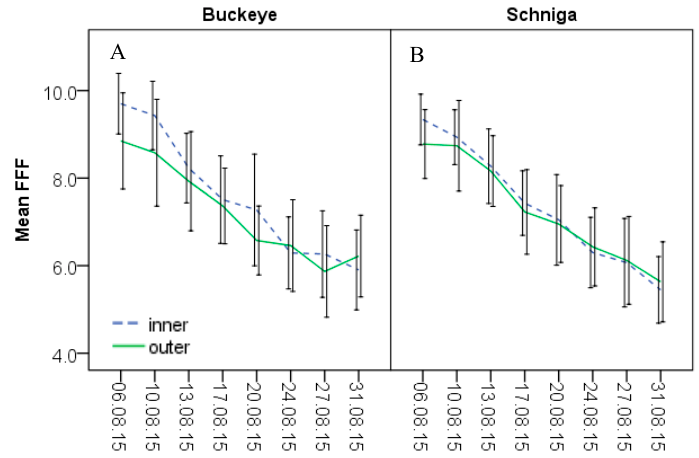
Figure 3. Changes (mean and standard deviation) of firmness (FFF) in the inner and outer canopy fruit during maturation (6 August to 31 August) in season 2015 for ( A ) cv. ‘Gala Buckeye’ and ( B ) cv. ‘Gala Schniga’.